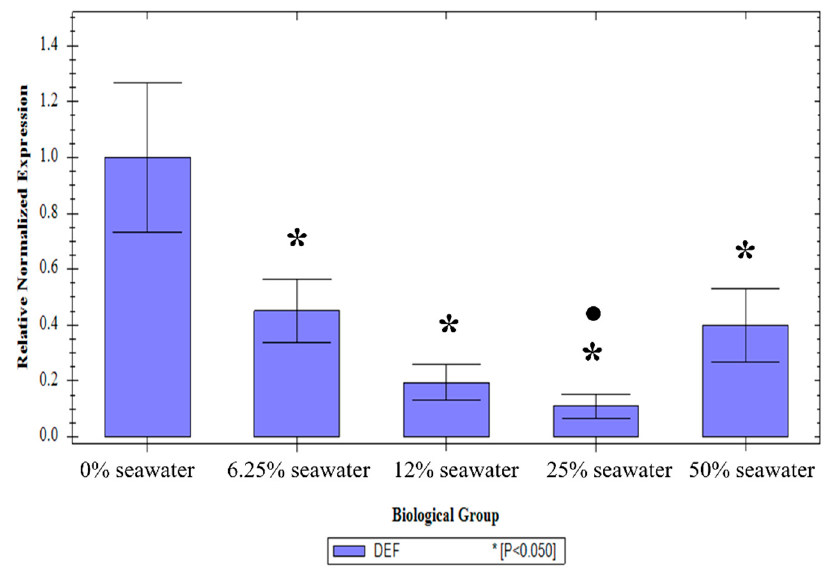
Figure 2. Relative normalised expression of defensin-1 transcripts from An . Merus adults reared in different larval salt concentrations. Asterisks (*) denote a significant difference from the untreated control. Circles ( • ) indicate a significantly lower expression in the treated groups.